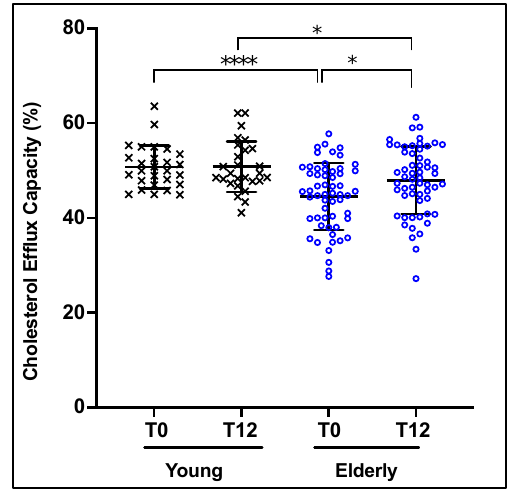
Figure 2. EVOO intake improves the CEC of HDL from healthy elderly subjects. Healthy young and elderly subjects consumed EVOO for 12 weeks. The CEC of HDL from each age group (young and elderly) were evaluated. HDL were incubated for 24 h with ( 3 H)-cholesterol-loaded J774 macrophages. The CEC of HDL was determined by measuring the percentage of radiolabeled cholesterol transferred to HDL and calculated as (cpm in medium/(cpm in medium + cpm in cellular lysates)) × 100. Results are expressed as mean ± SD ( n = 27 young and n = 57 elderly healthy subjects). * p < 0.03 and **** p < 0.0001.